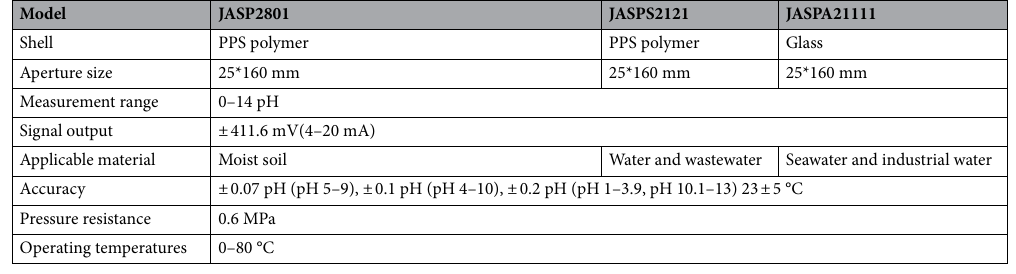
Table 5. Comparisons between different pH sensors.